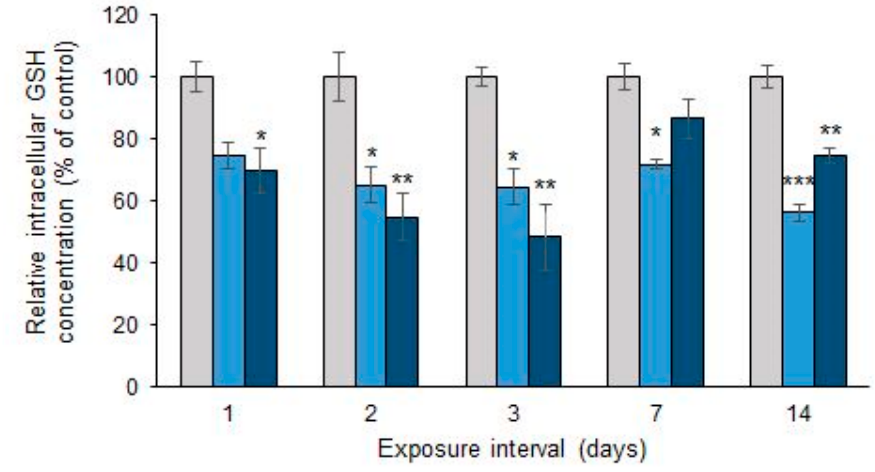
Figure 7. Effect of exposure of CD1 mice at doses of 5 and 15 mg Fe/kg bw of MNP-DSPE-PEG on the level of GSH in the liver, after 1, 2, 3, 7, and 14 d. Values are calculated as mean ± standard deviation (SD) and expressed as percentages related to the control group; the results were considered statistically significant when * p < 0.05; ** p < 0.01; *** p < 0.001 versus the control group.